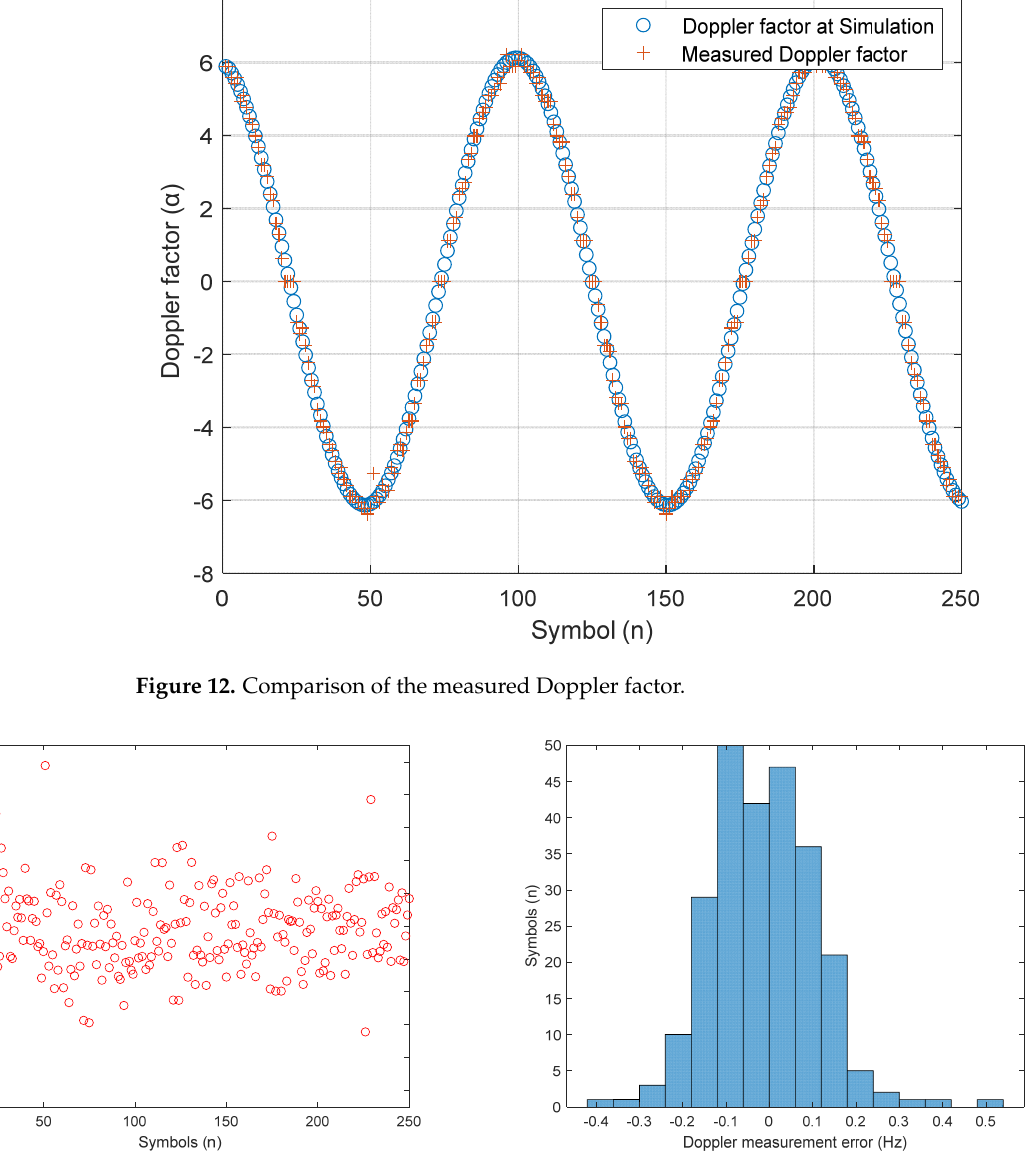
Figure 13. ( a ) Doppler error, ( b ) Histogram of the estimated Doppler error.